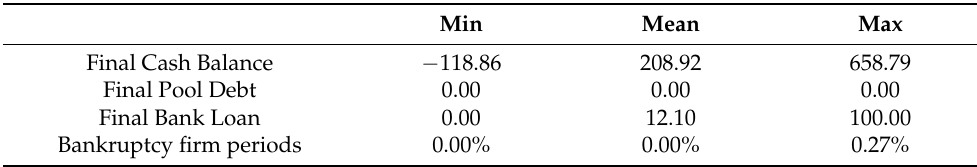
Table 5. Results for the base case without any cooperation and with an interest rate difference (0.50%-0.50%-0.75%).